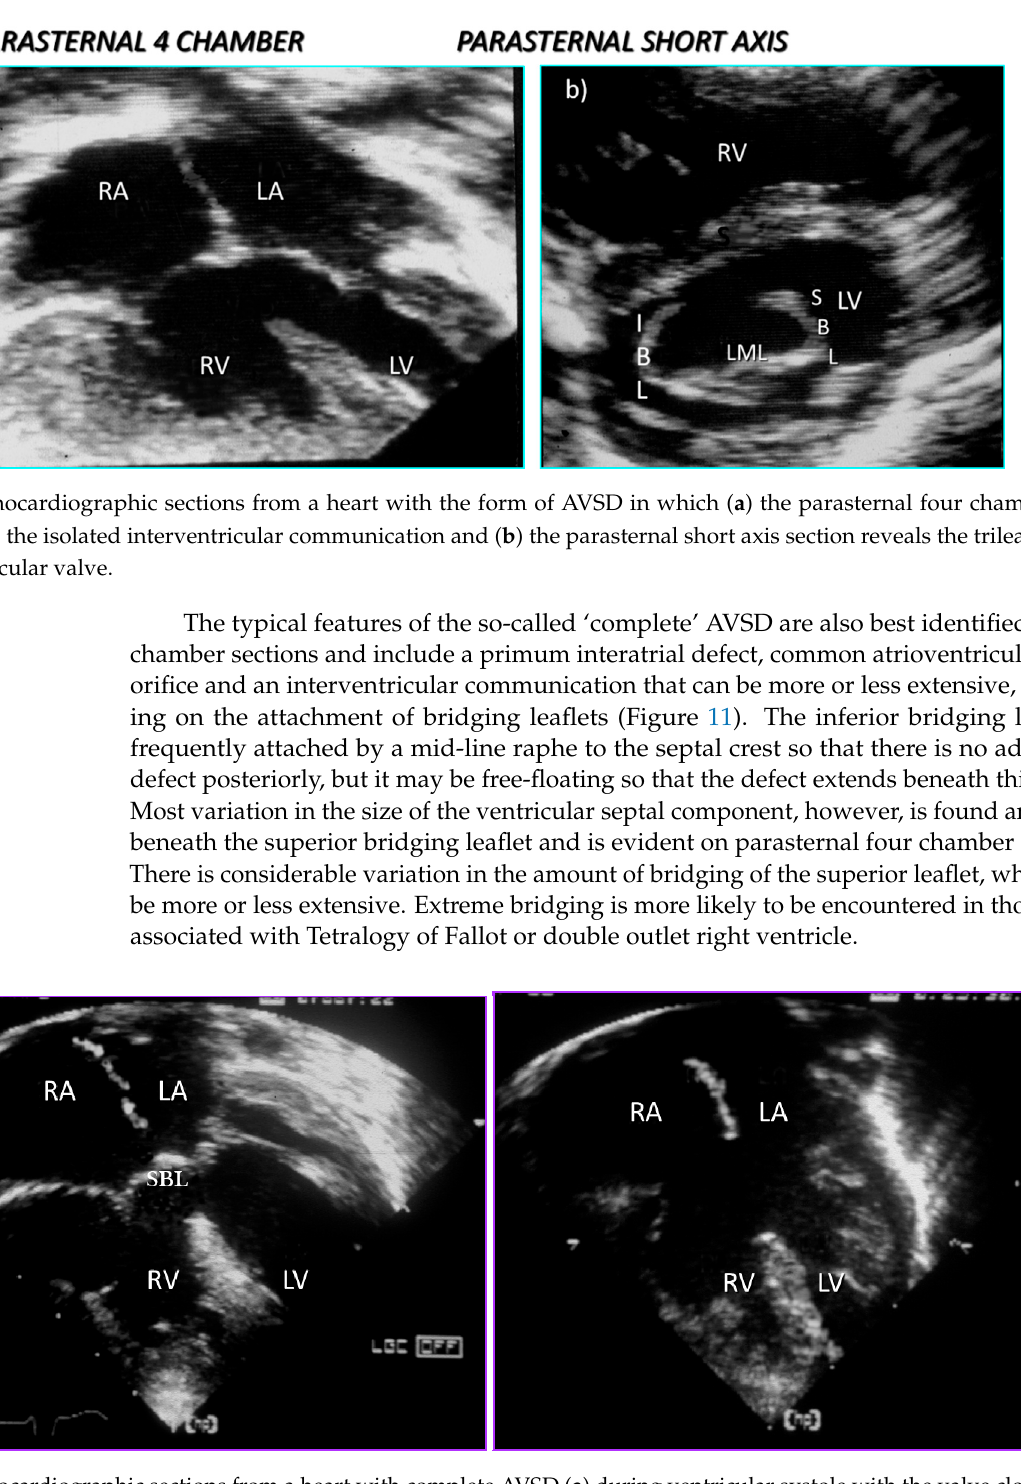
Figure 11. Echocardiographic sections from a heart with complete AVSD ( a ) during ventricular systole with the valve closed and ( b ) during diastole with the valve open.